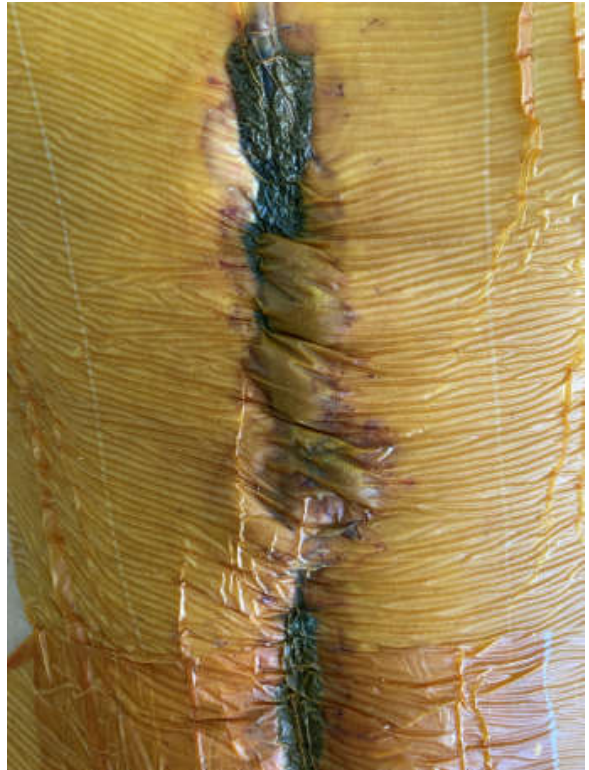
Figure 2. A view of the drain—the lower holes are put over the fistula, while the upper ones are enveloped with a black foam contacting the wound.